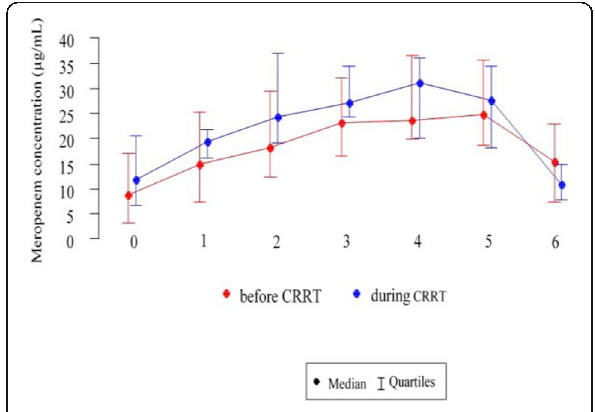
Fig. 1 (abstract 001597). See text for